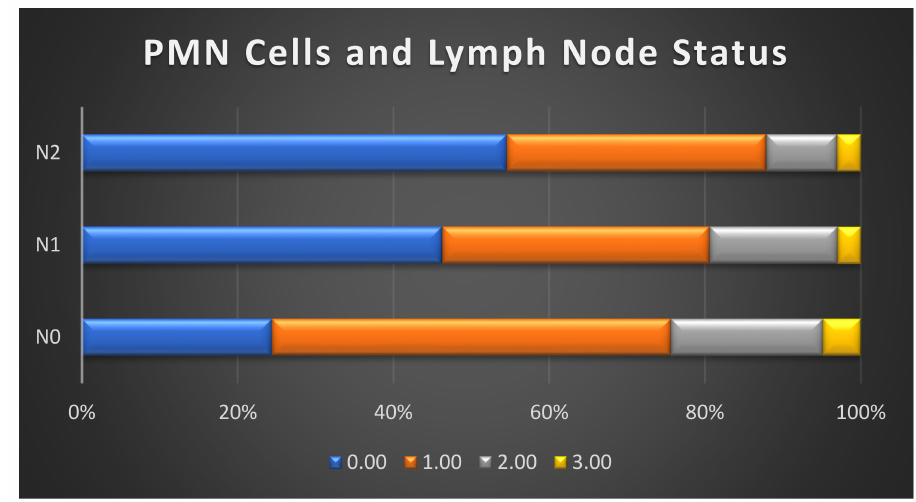
Figure 2. Association between tumour-associated MMP-8 positive polymorphonuclear cells (PMNs) and lymph node status. 0 = no PMNs; 1 = single PMNs; 2 = moderate number of PMNs; 3 = large number of PMNs.